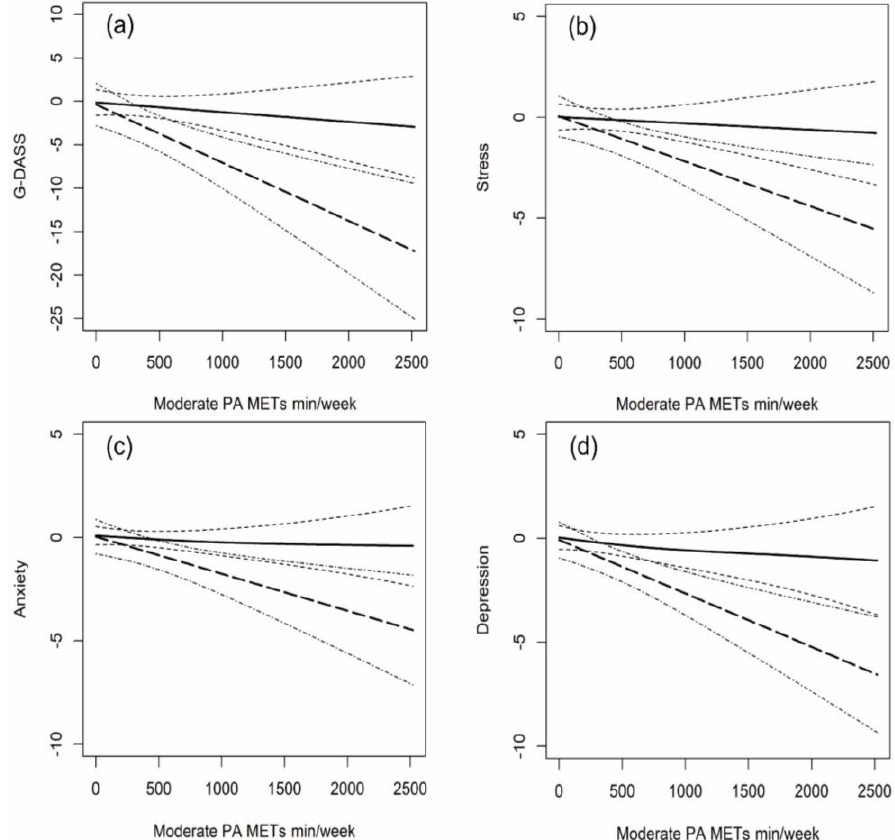
Figure 2. Dose-response relationships between moderate intensity physical activity and mental health indicators under healthy and unhealthy sleep status. Note: PA, physical activity. The subgraph of ( a – d ) indicates the dose-response relationship between moderate PA and different psychological indicators when at healthy or unhealthy sleep status. Non-linear splines for moderate intensity PA (METs-min/week) were used in a mixed-effect model with a random effect on individuals. The value of the Y -axis indicates the decrease of global negative emotions, stress, anxiety, and depression with the increasing moderate intensity PA. The bold-solid and bold-dash lines represent the relationship between moderate-intensity PA and mental health indicators under healthy and unhealthy sleep status, with thin-dash and thin-dot-dash lines indicating their 95% confidence interval, respectively. The range of stress, anxiety, and depression was all 0–21, and that of global negative emotions was 0 – 63.